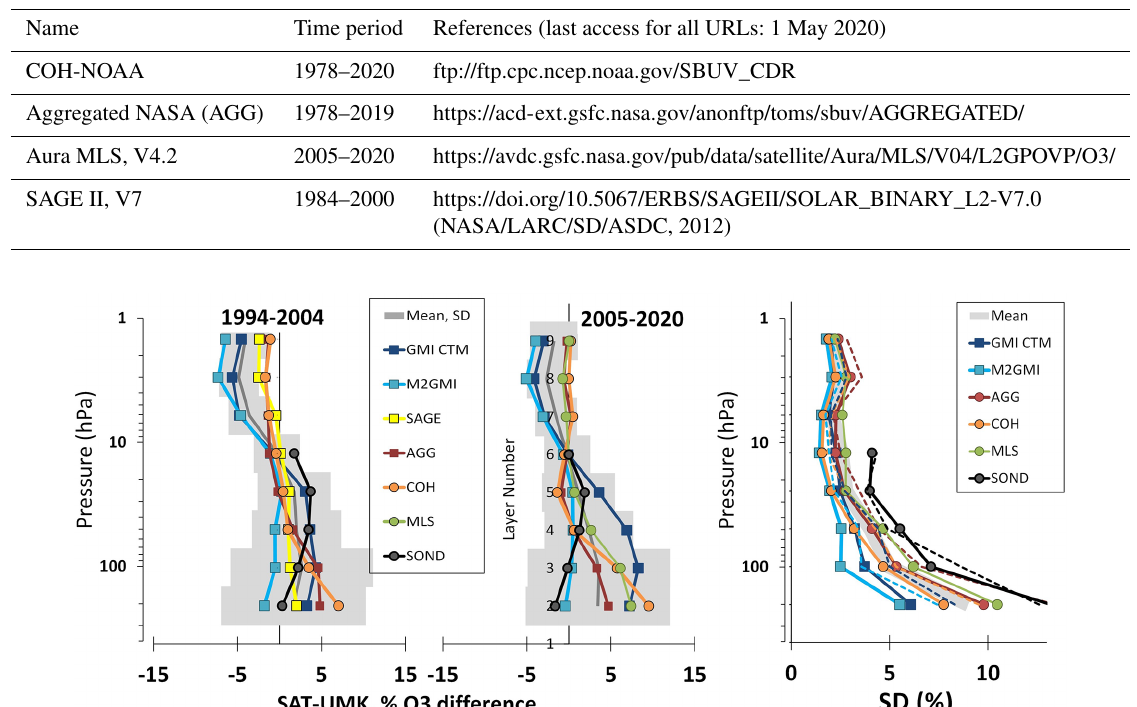
Figure 5. Same as Fig. 1a, but comparisons are against the Umkehr version with optimized stray light